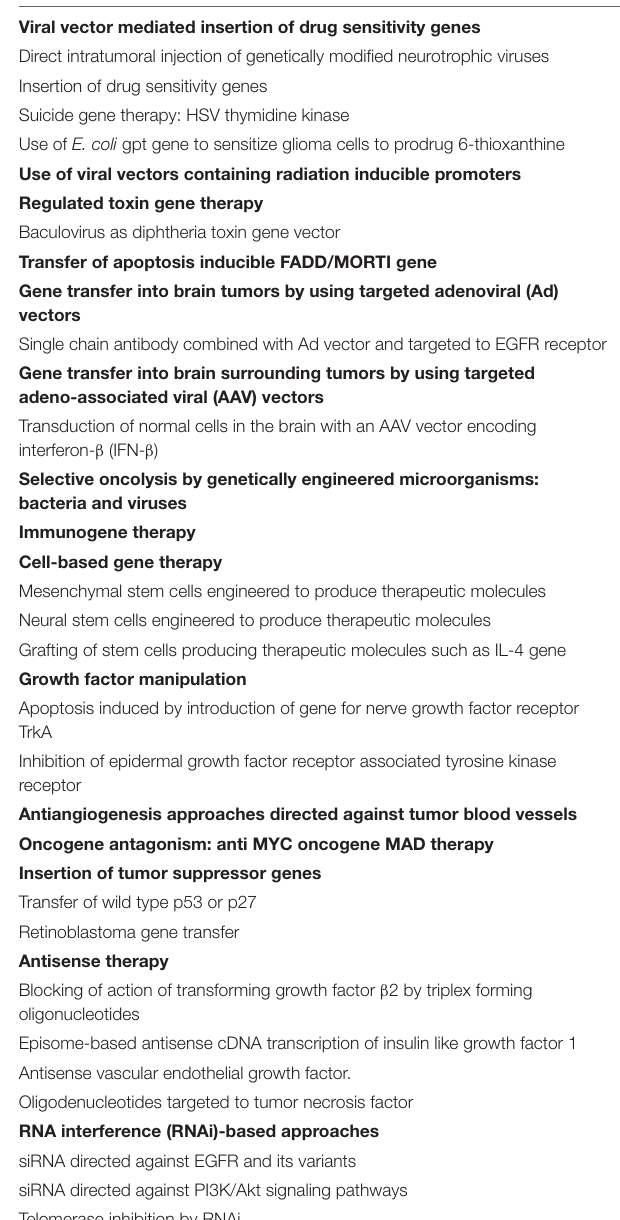
TABLE 3 | Strategies for gene therapy of